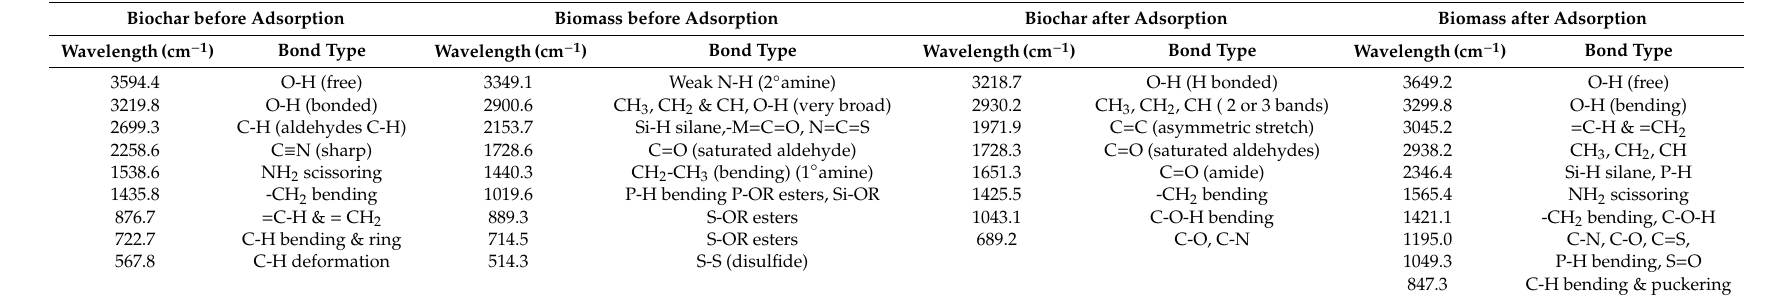
Table 2. FTIR analysis of biochar and biomass of Sterculia alata fruit shell, before and after the adsorption